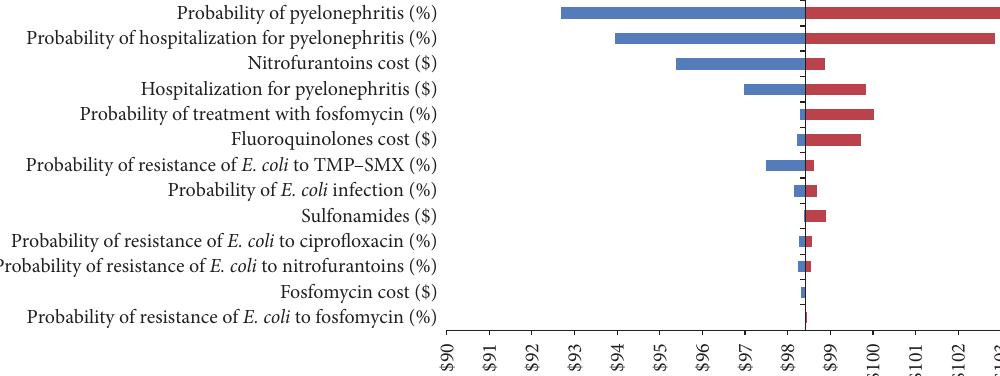
Figure 9: Tornado diagram comparing the results of the one-way sensitivity analyses of variables potentially affecting the expected value of cost-per-patient (chance